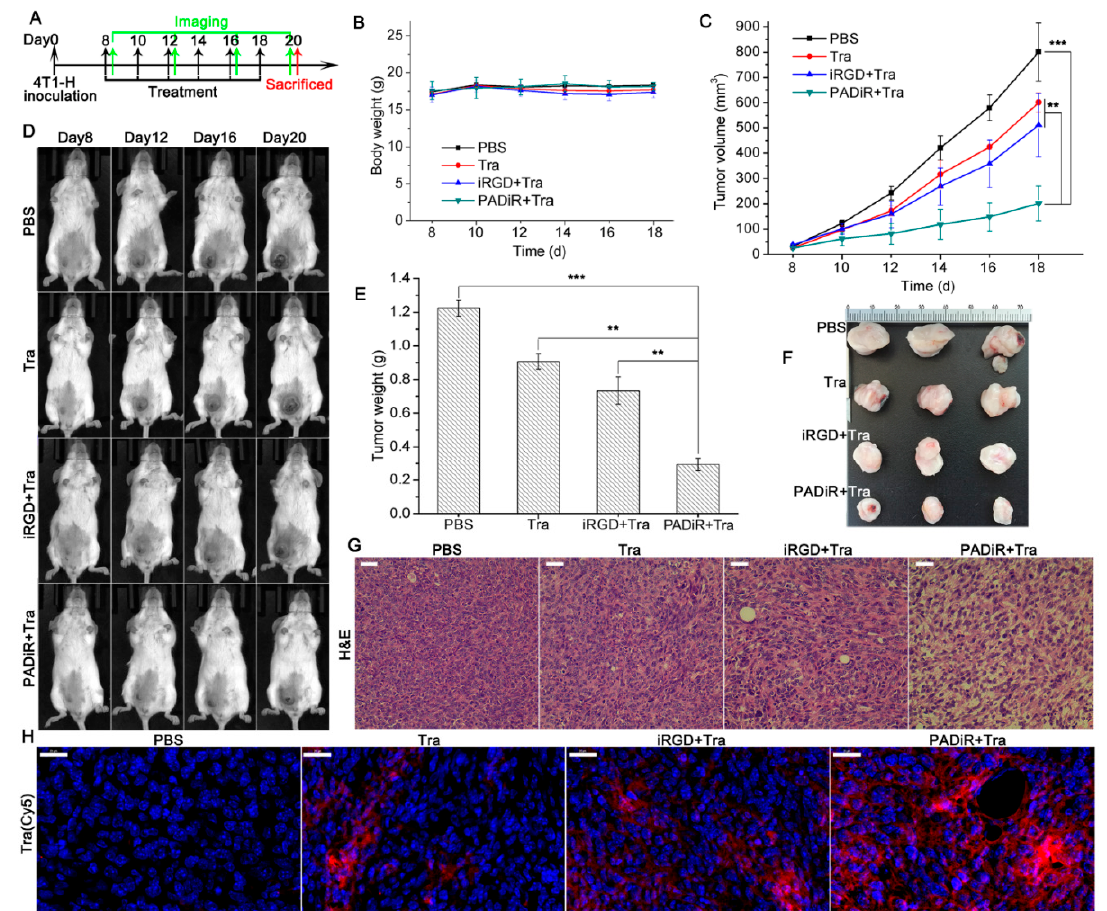
Figure 4. Enhanced antitumor e ff ects of trastuzumab (Tra) coadministered with PADiR peptosomes. ( A ) Scheme of coadministration therapy: 4T1-H orthotopic tumor-bearing mice were injected with Tra and PADiR every other day; ( B ) the body weights of the mice in each group during the therapy. Data are shown as mean ± SD ( n = 5); ( C ) the growth curves of tumors from the mice treated with phosphate-bu ff ered saline (PBS), Tra, iRGD + Tra, and PADiR + Tra in the therapy study. Data are shown as mean ± SD ( n = 5), ** p < 0.01, *** p < 0.001; ( D ) representative images showing tumor growth during the therapy; ( E ) average tumor weights from the mice in each group after the therapy. Data are shown as mean ± SD ( n = 5), ** p < 0.01, *** p < 0.001; (F) representative images of excised tumors from the mice treated with PBS, Tra, iRGD + Tra, and PADiR + Tra; ( G ) histological analysis using hematoxylin-eosin (H&E) staining of tumor slices from each group after the treatment; scale bars: 50 µ m; ( H ) analysis of Tra (Cy5 labeled) enrichment in tumor tissues using immunofluorescence staining (DAPI: blue, Tra: red, and scale bars: 50 μ m).